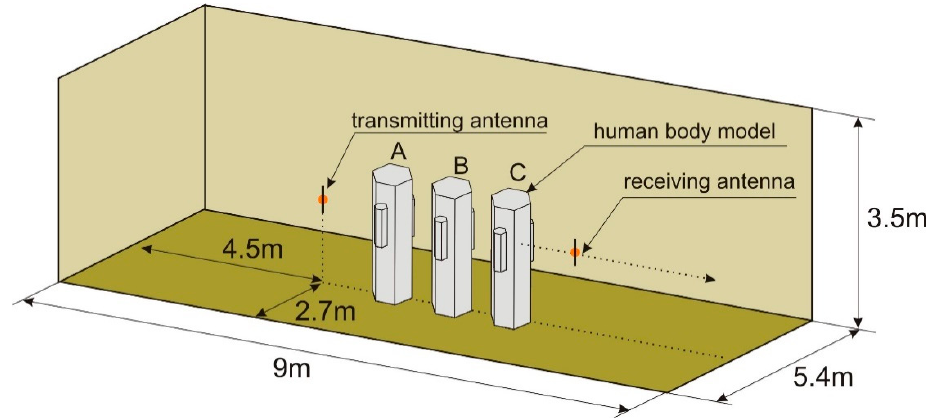
Figure 9. Geometry of the indoor scenario for simulating the shadowing effect in XGtd™ (picture not to scale).